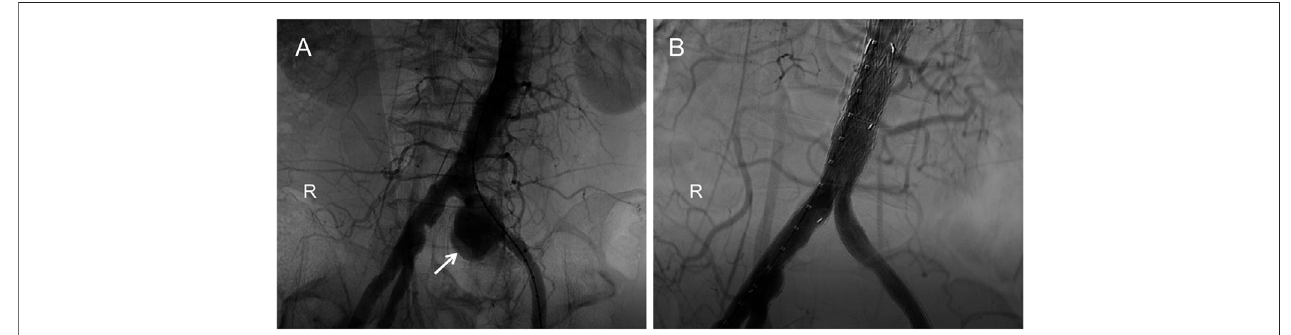
FIGURE 2 | Digital subtraction angiography (DSA): (A) . The pseudoaneurysm was observed by contrast-medium over fl ow (white arrow). (B) . Postoperatively, angiography showed no contrast-agent spillage in the left common iliac artery.